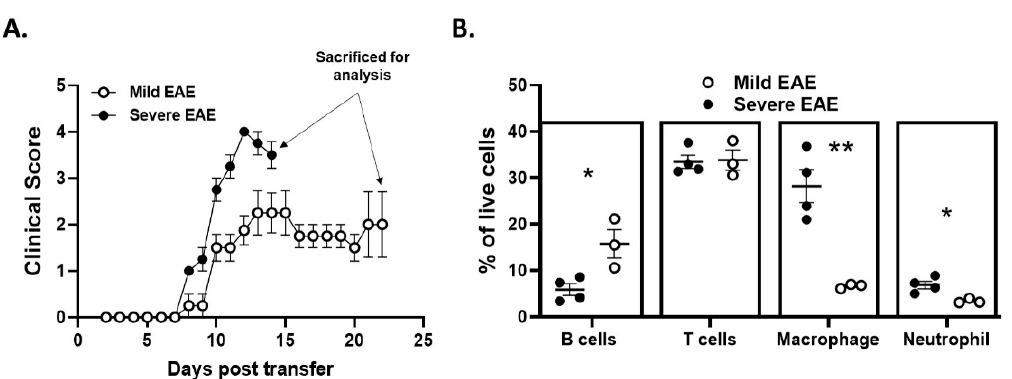
Figure 6. Disease duration and/or severity affects B-cell and myeloid cell accumulation into the CNS of mice. Recipient mice received donor Th17 cells and were not treated with PTX. Severe EAE: sacrificed on day 14, n = 4/group; Mild EAE: sacrificed on day 22, n = 3/group. ( A ) EAE scores were monitored in mice with mild and severe EAE. ( B ) Comparison of the percentage of B cells, T cells, macrophages and neutrophils in the spinal cords was assessed by flow cytometry in the mild and severe EAE mice on the day of sacrifice. Statistical differences were found using Student’s t -tests. * p < 0.05 and ** p < 0.01. B cells: CD19 + ; T cells: CD4 + ; Macrophages: CD11b + F4/80 + ; Neutrophils: CD11b + Ly6G + .